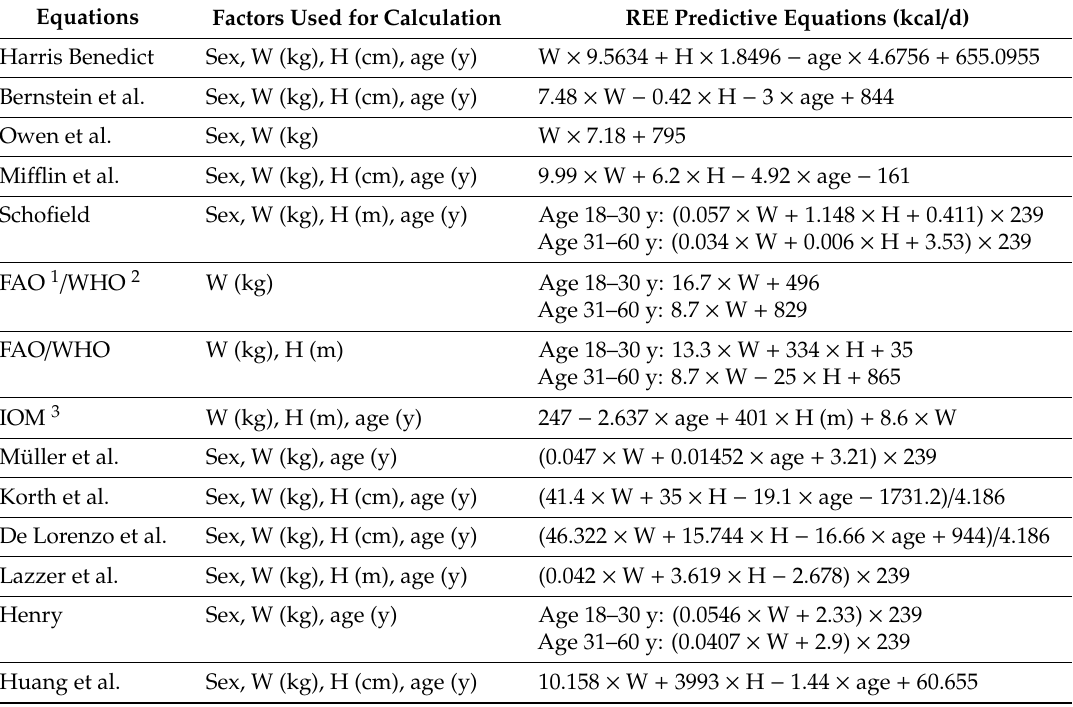
Table 1. Resting energy expenditure (REE) predictive